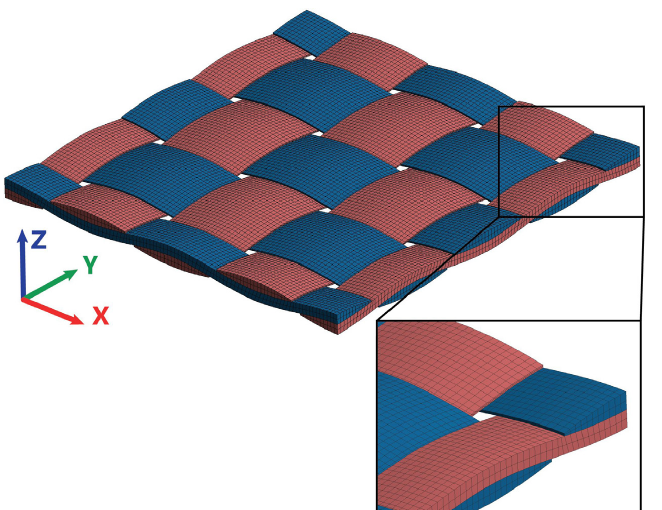
Figure 6. FEM model of one of the weave patterns. Longitudinal threads are blue, and transversal threads are